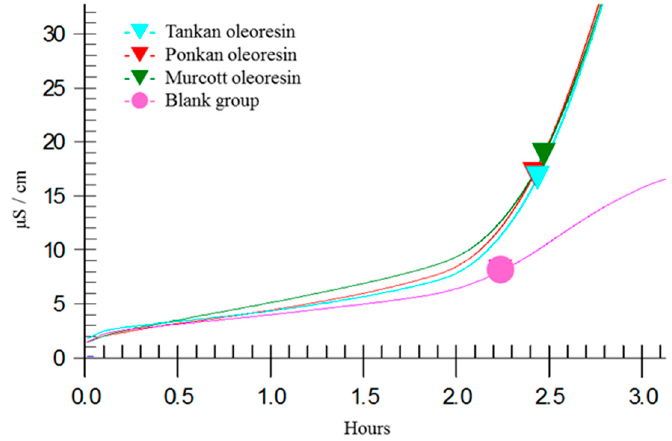
Figure 3. Oxidation curves obtained for the oleoresin samples extracted from the three citrus varieties as determined by Rancimat.